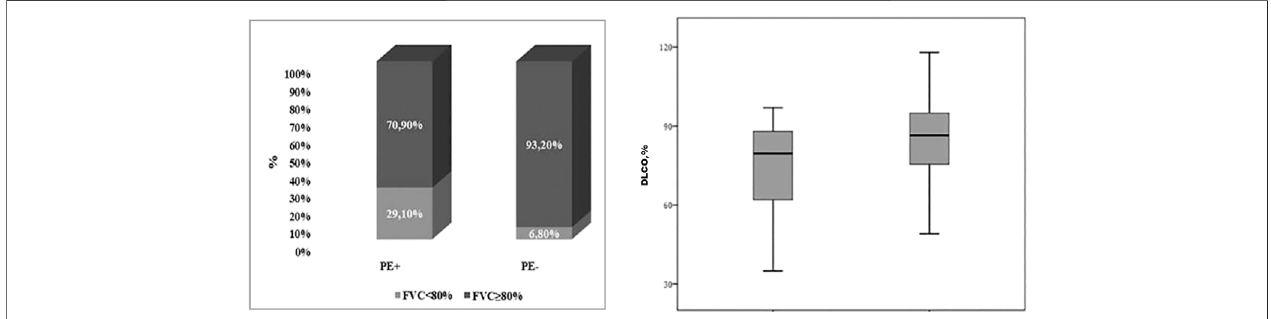
FIGURE 1 | Box-plot showing differences between PE+ AND PE − in terms of FVC% < 80% (29.1 vs 6.8%, p (cid:1) 0.033) (on the left) and in terms of DLCO% [79.5 (61 – 89.5) vs 86.5 (75.3 – 95.5); p (cid:1) 0.023] (on the right). PE, Pulmonary Embolism; FVC, Forced Vital Capacity; DLCO, Diffusion capacity of the lungs for carbon monoxide; LLN, Lower Limit of